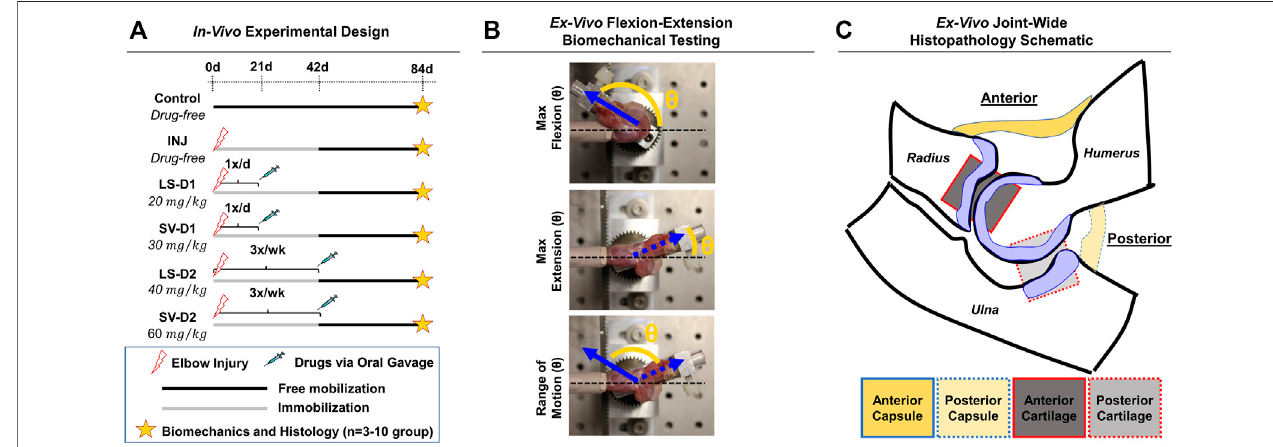
FIGURE 1 | Experimental design for in vivo rat elbow injury model. (A) Summary of experimental groups, timeline, and post-mortem analysis. Control is uninjured, age-matched animals. For drug strategies, INJ is an injury with no treatment, while losartan (LS) and simvastatin (SV) represent injury plus LS and SV, respectively; dosage strategy 1 (D1) and dosing strategy 2 (D2) represents the treatment strategies of low dose/high frequency/short duration vs. high dose/low frequency/long duration,respectively. (B) Imagesdepictingthe exvivo fl exion-extensionbiomechanical testingset-upand thequantitative angularmeasurements obtained. Inthis elbow injury model, elbow contracture is characterized by i) decrease in the total range of motion, ii) increase in max extension angle (which translates into decreased elbow extension), and iii) unaltered max fl exion. The total range of motion is calculated by determining the angle difference between max extension and max fl exion. (C) Schematic of an elbow mid-sagittal section with the corresponding anatomical location of the capsule and cartilage for histopathology.